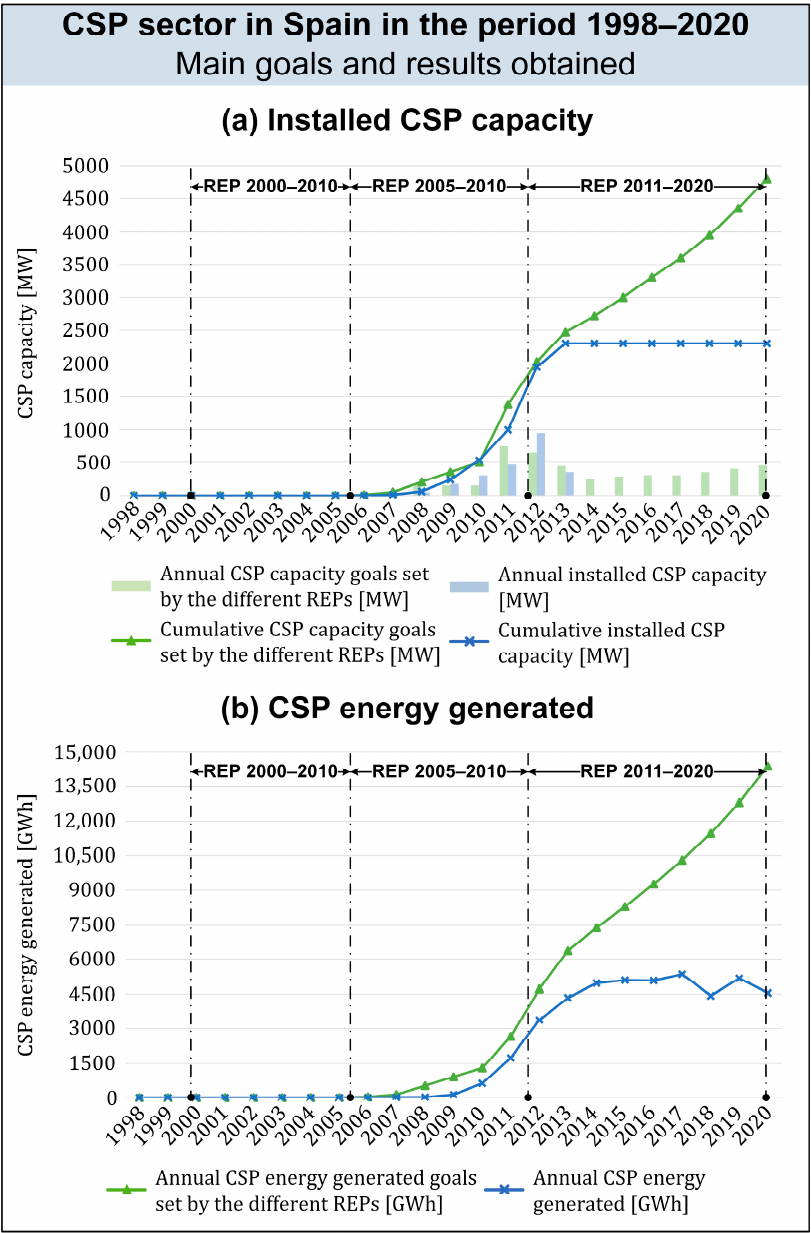
Figure 2. Evolution of the CSP sector in Spain in the period 1998–2020 in terms of: ( a ) installed CSP capacity; ( b ) CSP energy generated. Source: self-elaboration based on [62,66,68,69]. In Figure 1a, the cumulative PV capacity goals set by the different REPs are repre- sented with a green solid line with triangle symbols, while the actual cumulative installed PV capacity is plotted by a red solid line with cross symbols. In turn, the annual PV ca- pacity targets set by the different REPs are represented with green-colored vertical bars, while the actual annual installed PV capacity is plotted with red-colored vertical bars. In Figure 1b, the annual PV energy generated goals set by the different REPs are shown using a green solid line with triangle symbols, while the actual annual PV energy generated is represented by a red solid line with cross symbols.